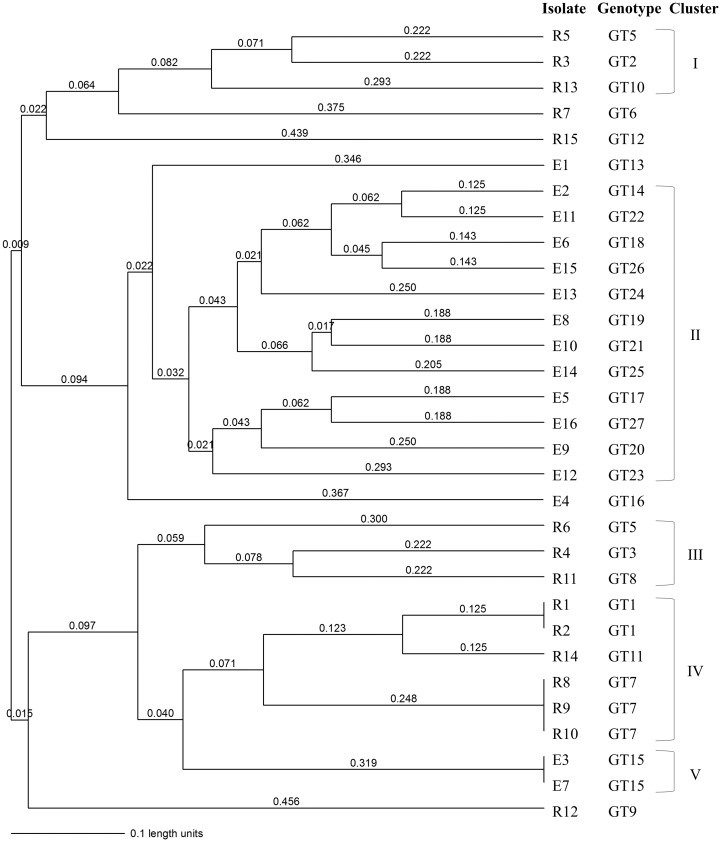
Genetic relationships of 31 A. terreus isolates according to source.The dendrogram is based on a categorical analysis of seven microsatellite markers in combination with unweighted pairgroup method using the arithmetic average (UPGMA) clustering. The number on the tree indicates the branch length, showing the difference along a branch. All 31 isolates (R1 to R15 and E1 to E16) comprised 27 distinct genotypes (GT 1 to GT 27) by 7 microsatellite markers. However, when a cluster is defined as the isolation of two or more strains with a branch length distance of < 0.63, ear isolates comprise clusters II and V, and the respiratory isolates comprise clusters I, III, and IV, suggesting a closer genetic relatedness among isolates from the same body site (ear or respiratory tract). Five isolates (R7, R15, E1, E4, and R12) were unique to a single isolate, which did not cluster with other isolate as a branch length distance of < 0.63. See Table 2 for detailed information on each isolate.